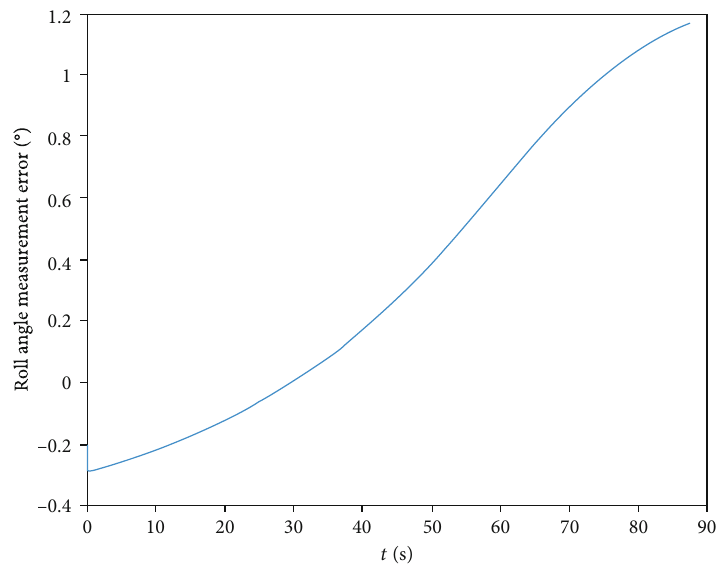
Figure 4: Roll angle error input with pitch